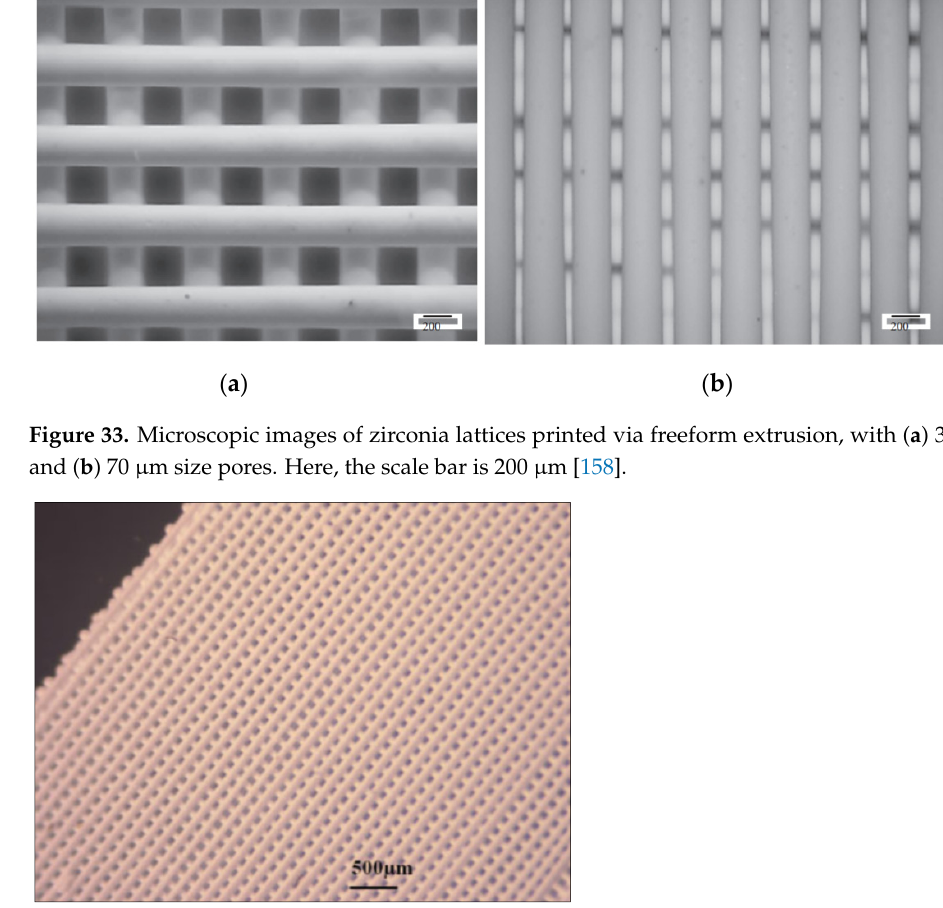
Figure 34. A fine ceramic (calcium phosphate) lattice printed via freeform extrusion and with a mesh spacing/pore size of 70 µ m. Calcium phosphate is biocompatible and commonly used as bone substitution material. Here, the scale bar size is 500 µ m. (Reprinted from [154], with the permission of John Wiley & Sons Inc).